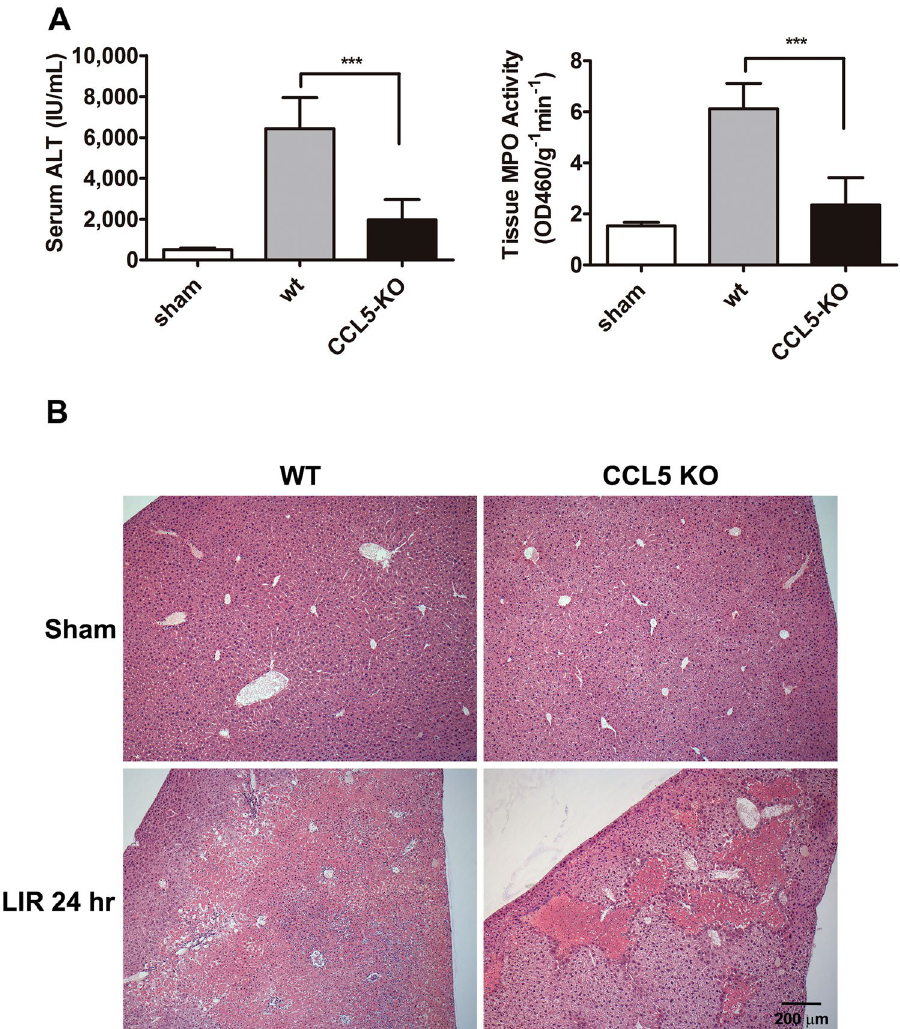
Figure 4. Mice with deletion of the CCL5 gene exhibited alleviated post-IR injury. Both C57BL/6 C and CCL5-KO mice were subjected to 60 min ischemia followed by 24 hours reperfusion. ( A ) The serum ALT and tissue MPO activities were measured in B6 and CCL5-KO mice (Mean ± SD, n = 12). *** p < 0.0001. ( B ) Histological studies (H&E stains) showed broad and widespread area of necrosis found in wildtype mice. A much smaller and more confined area of necrosis was observed in CCL5-KO mice. Scale bar = 200 μ